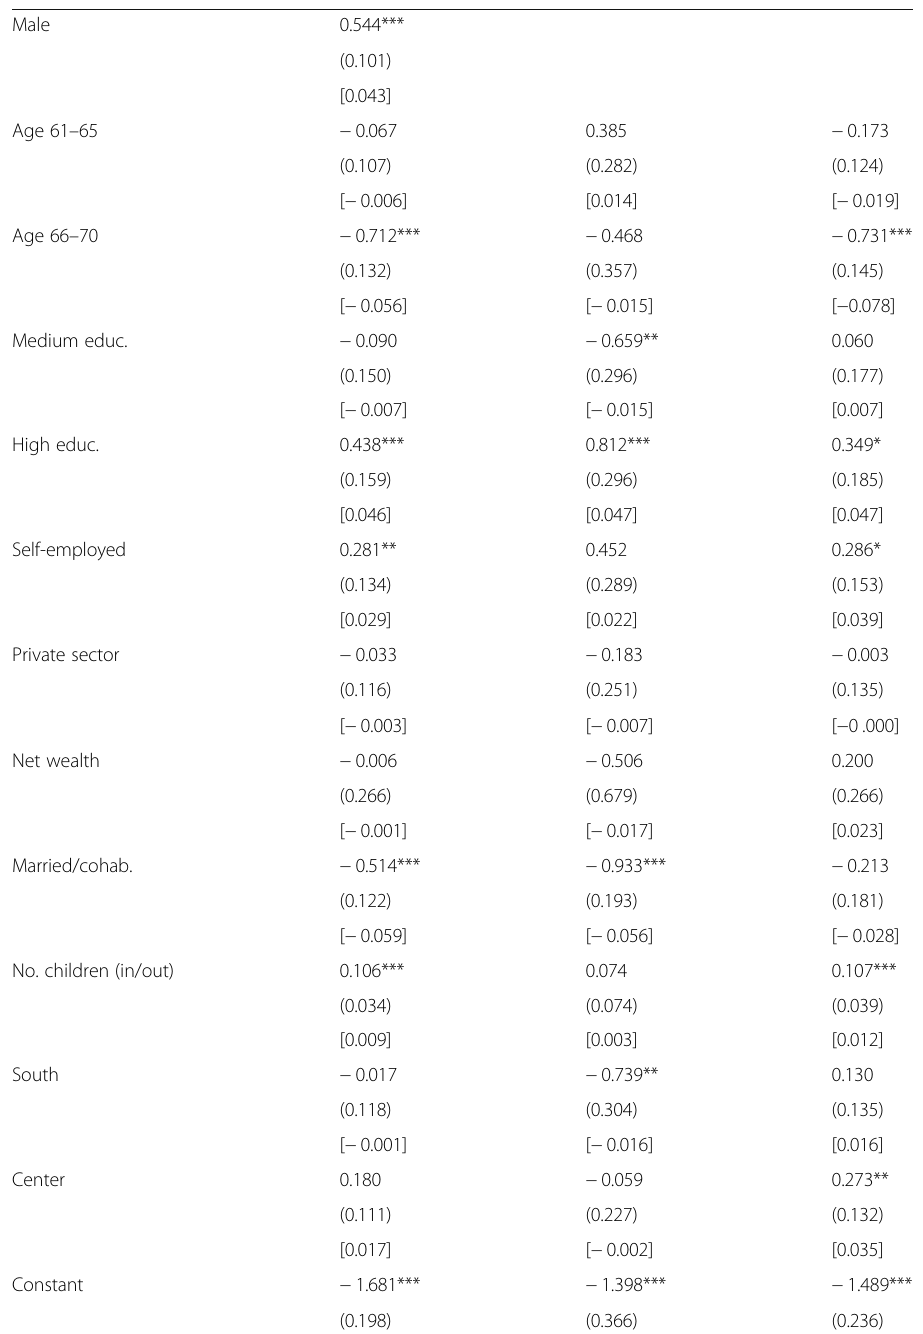
Table 3 Desired participation (probit), retired